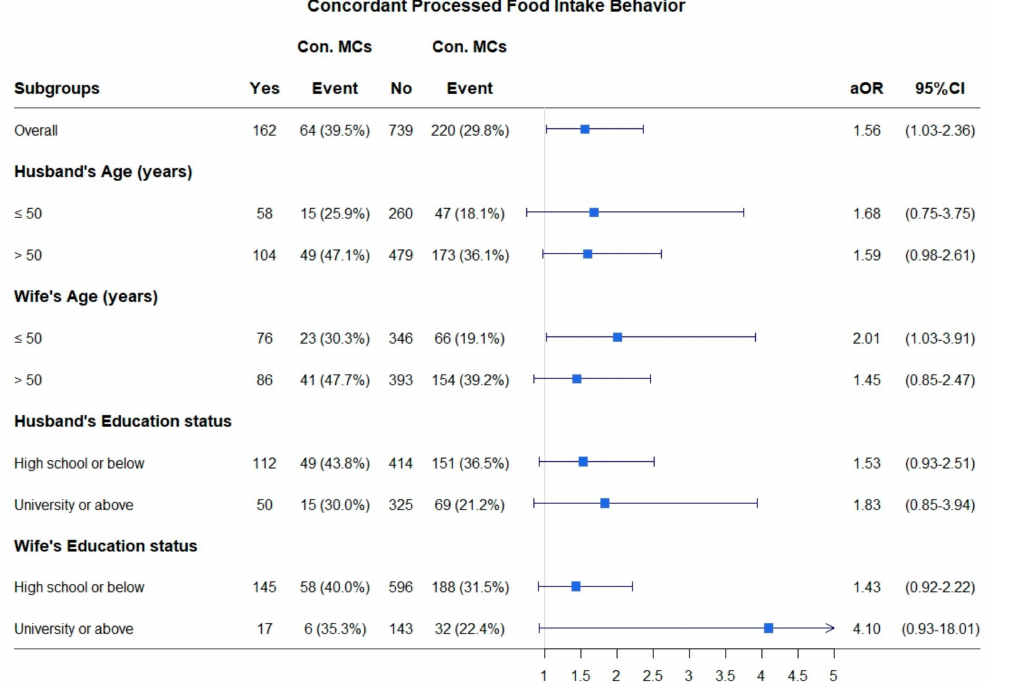
Figure 2. Stratified analysis for the association between concordant processed food intake behavior and concordant composite MCs. Con. MCs: concordant composite metabolic components; (cid:4) : aOR: adjusted odds ratio; CI: confidence